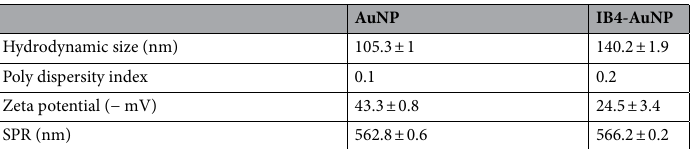
Table 1. Gold nanoparticle characterization. Data obtained from dynamic light scattering and spectrophotometric analysis of non-functionalized and IB4 functionalized AuNP. Data shown are mean ± standard deviation (S.D.), from three experimental replicates.